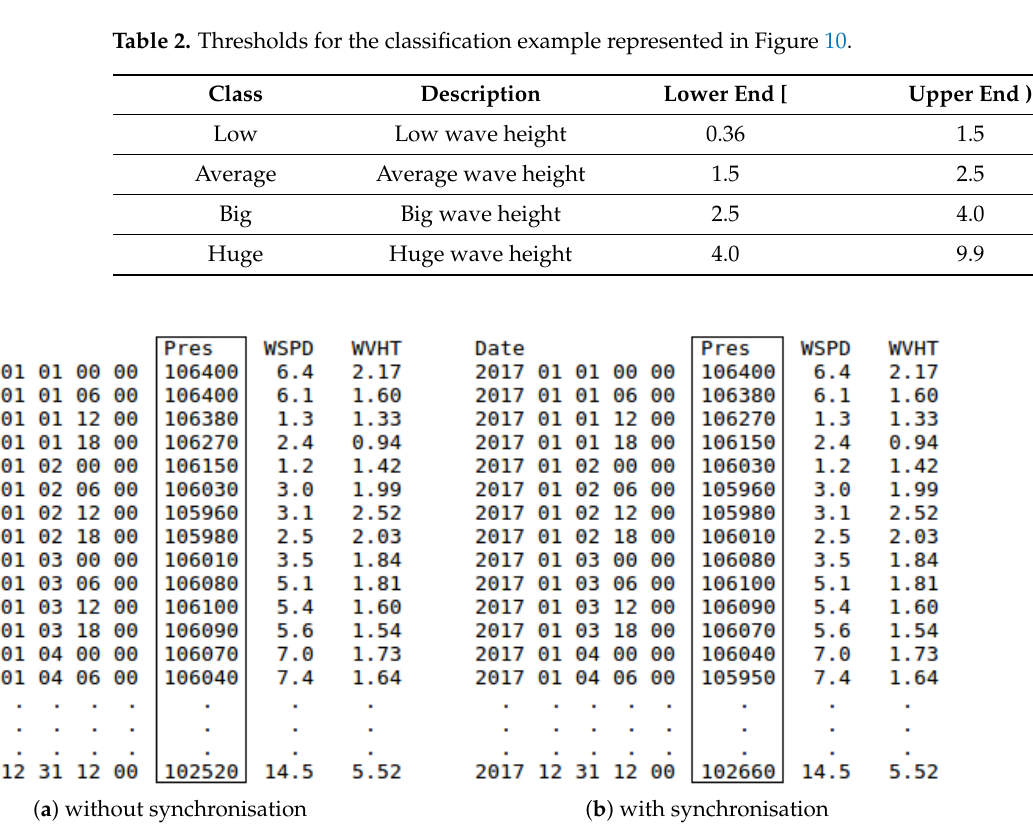
Figure 9. Example of the creation of a Regression dataset with a prediction horizon of 6